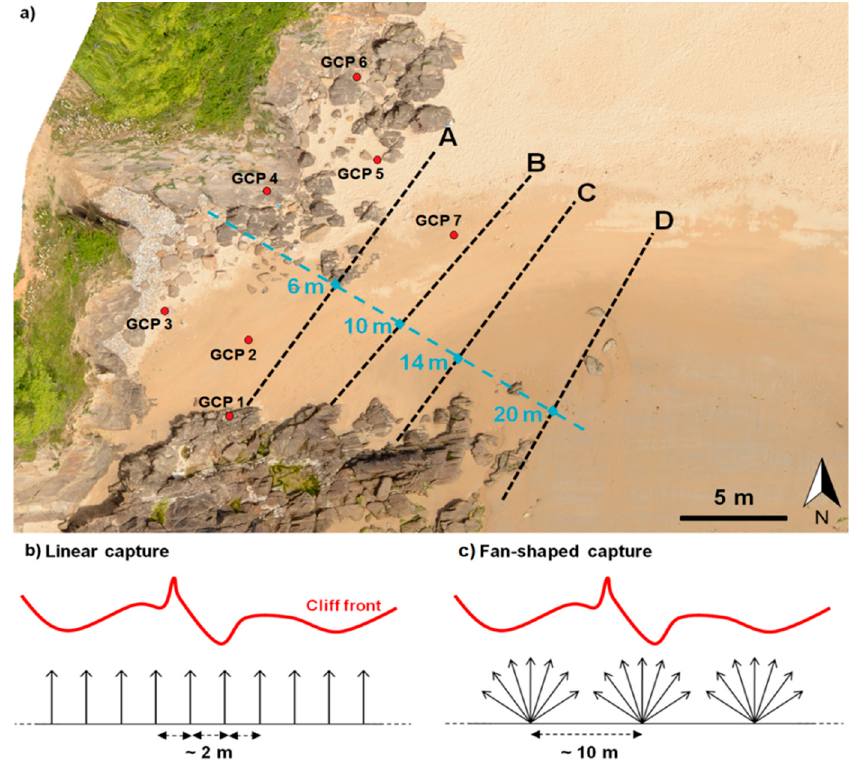
Figure 4. Operational mode for the second test on Porsmilin cliff (left of the image). ( a ) Position of the GCPs and of the segments A, B, C and D at respectively 6 m, 10 m, 14 m and 20 m from the cliff foot. ( b ), ( c ) Geometry of the shot modes tested along each segment, with linear capture ( b ) or fan-shaped capture ( c ).